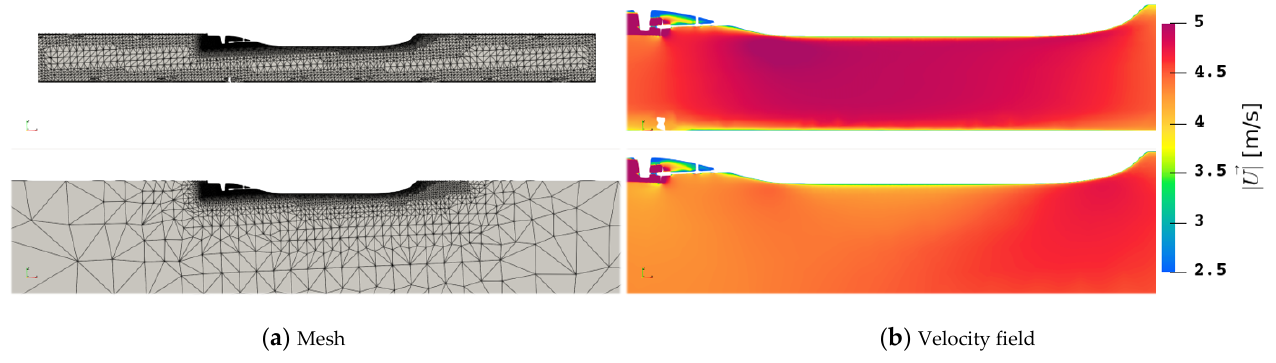
Figure 2. Midplane of cavitation tunnel and quasi-infinite domain.